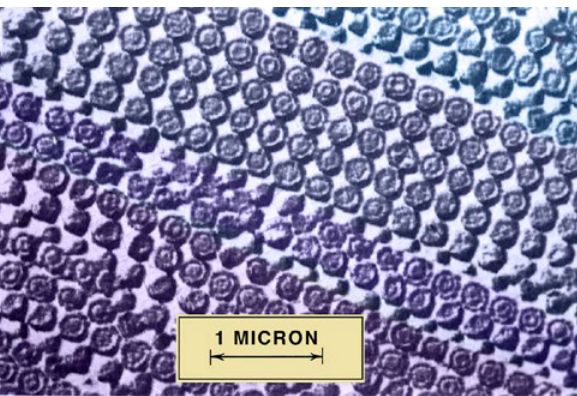
Figure 10. An electron micrograph of opal structure that has been lightly etched with hydrofluoric acid shows internal rings within the ordered silica spheres. Iler 2 (1979, p. 401) records as many as five internal layers. The size of the particles comprising the layers is 50nm but the opaline spheres have to be over 300nm before the interplay of colours can be